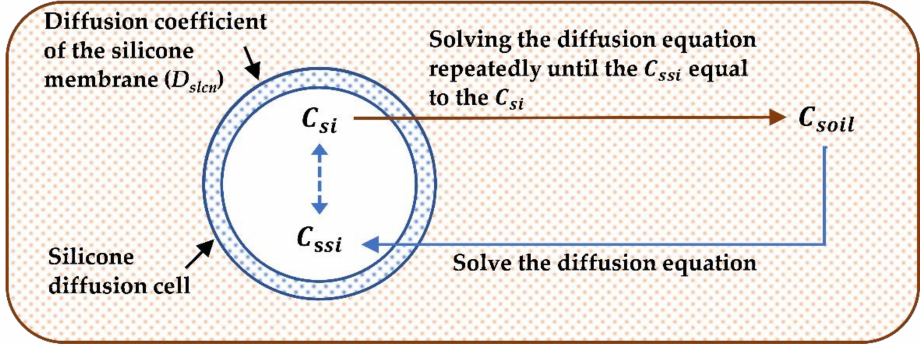
Figure 4. The repetitive simulation steps for obtaining the predicted N 2 O gas levels in